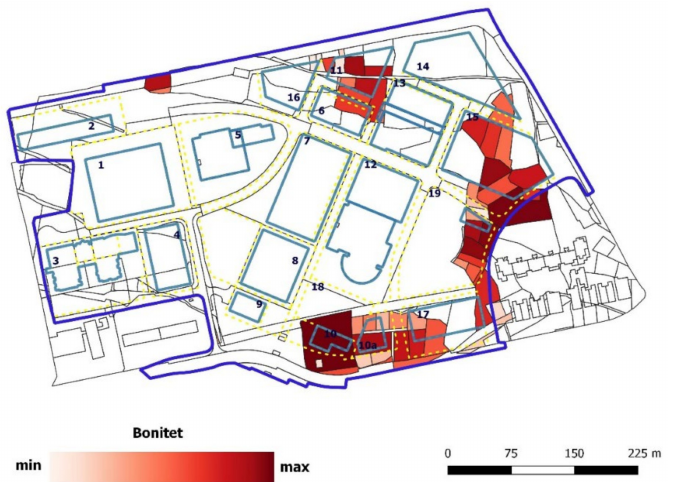
Figure 20. Bonitet values of private cadastral parcels in the project area of the University of Split